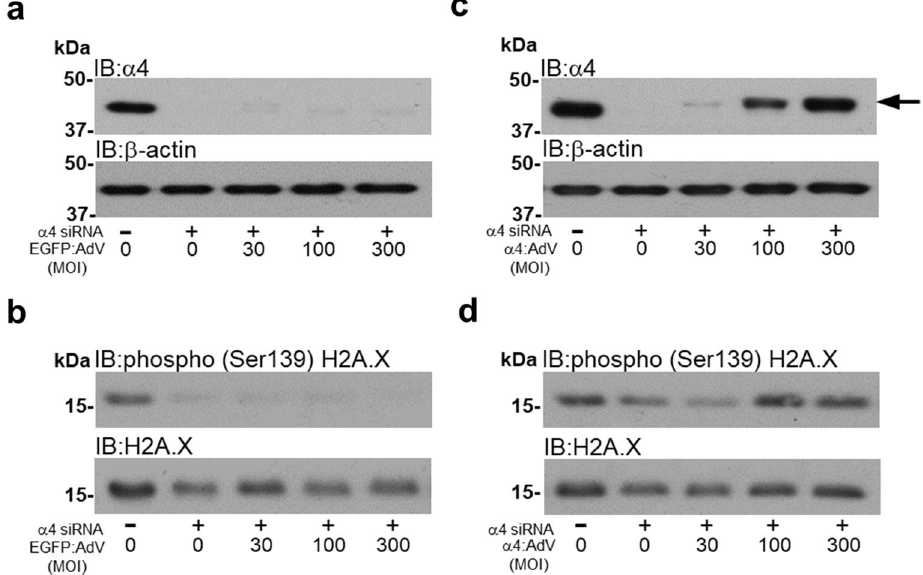
Figure 5. Recovery of α4 protein expression regulates H2AX Ser139 phosphorylation in cardiomyocytes. H9c2 cardiomyocytes were transfected with either 50 nM non-targeting control (NTC) siRNA or 50 nM siRNA specific to rat α4 protein (siα4) for 4 days. On day 3, cardiomyocytes that were infected with either EGFP ( a and b ) or α4 ( c and d ) expressing adenoviruses at 30, 100 and 300 MOI for 1 h and harvested 24 h later. The expression of α4 and phosphorylation of H2AX at Ser139 was determined by Western analysis using an antibody raised against human α4 and residues surrounding Ser139 of human H2AX, respectively. Western immunoblots are representative of 3 individual experiments. Expression of β-actin and total H2AX was used to confirm equal protein loading between